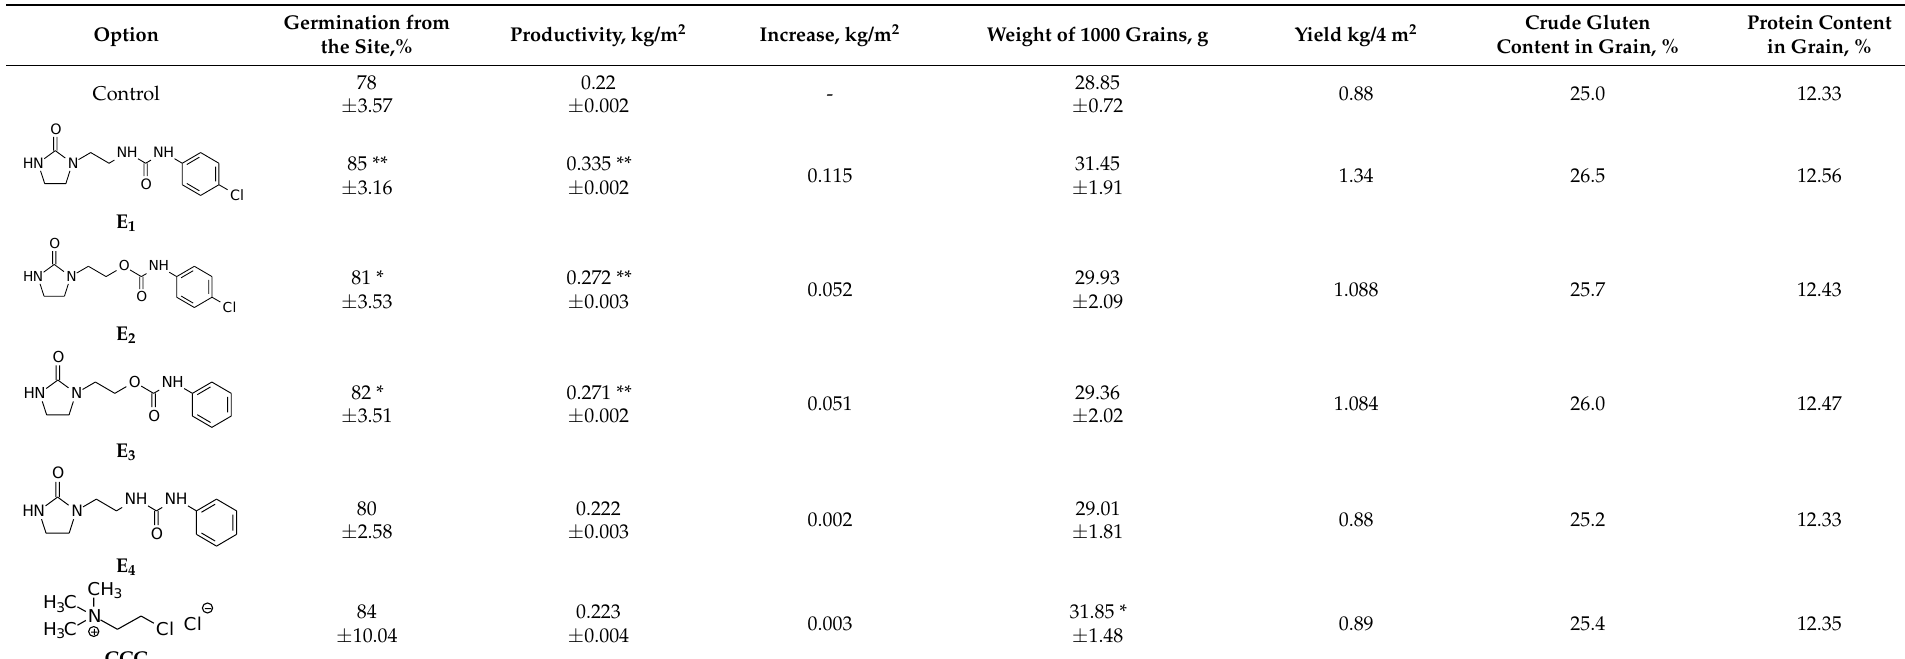
Table 3. Productivity of field experiments for testing compounds.